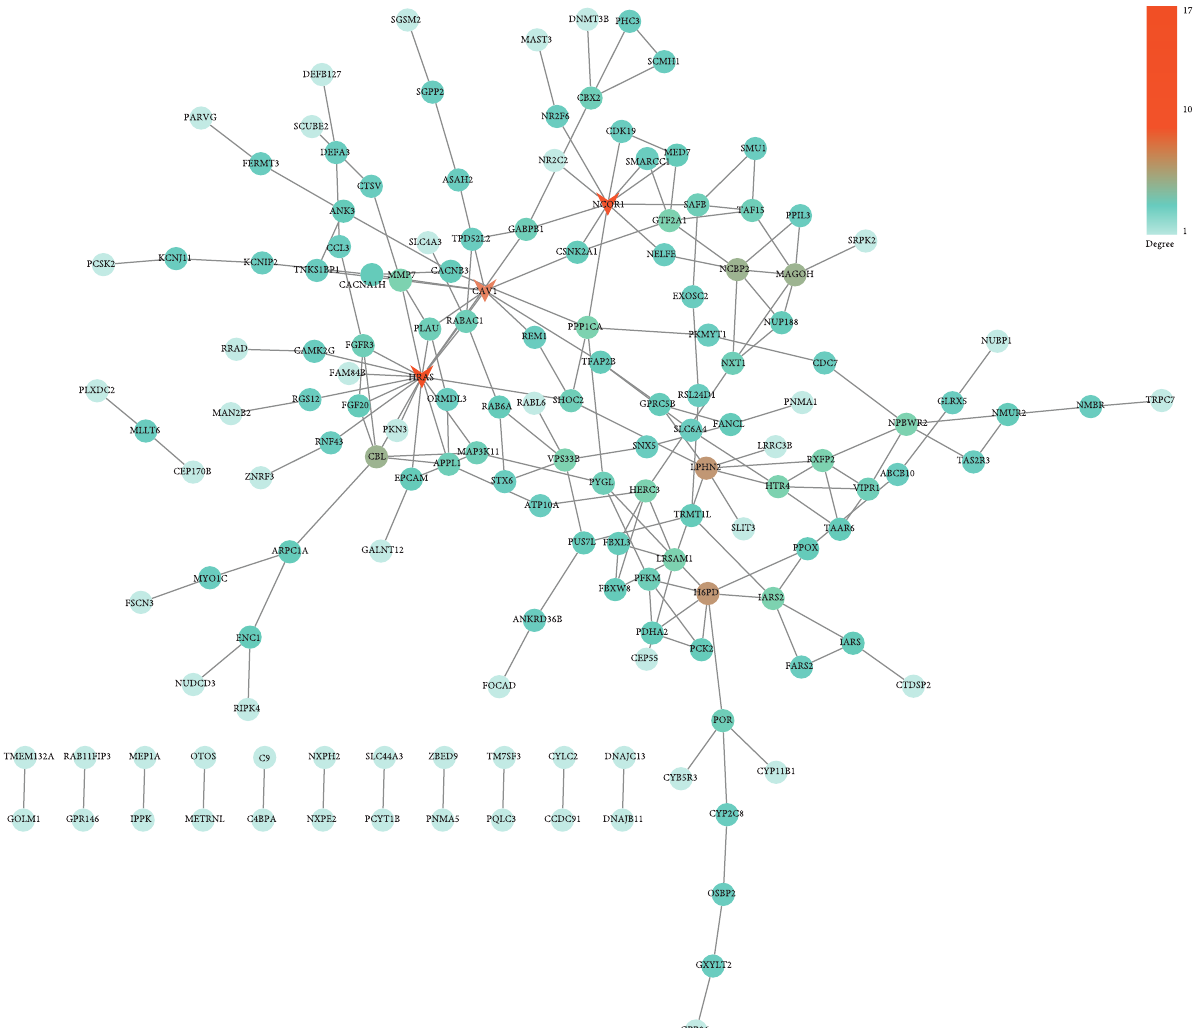
Figure 5: PPI network for downregulated DEGs. The nodes stand for the names of genes, and the edges stand for the interactions between genes. The color bar stands for the degree